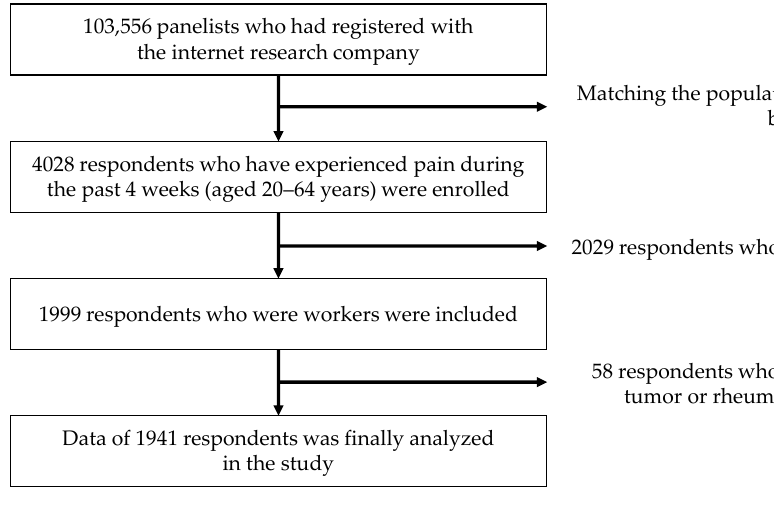
Figure 1. Flowchart of the sampling procedure for the analysis.